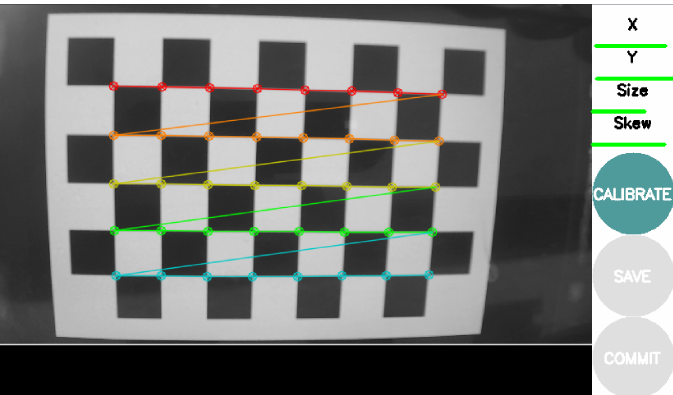
Figure 1. The camera_calibration labeling visual feedback is presented on the left, and bars of variation of parameters and user option are represented in buttons shown on the